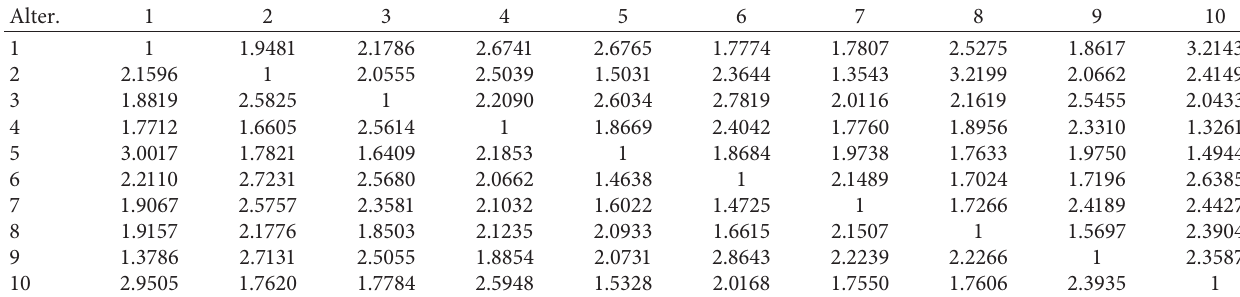
Table 9: Index value matrix X � [ x